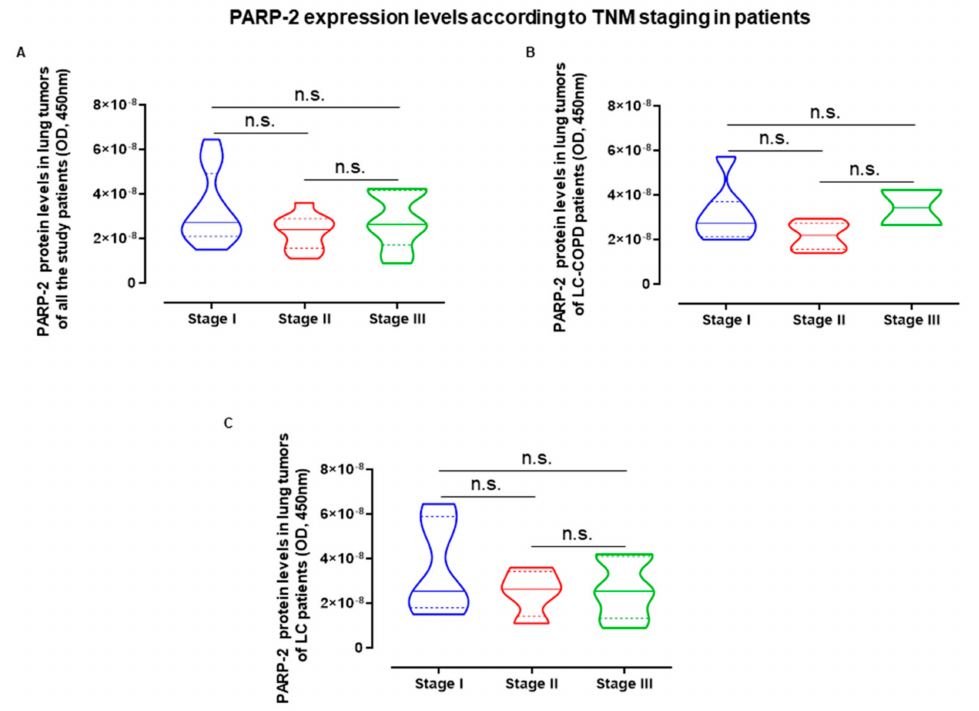
Figure 6. ( A – C ) Violin plots with median (continuous lines) and interquartile ranges (discontinuous lines) of PARP-2 expression levels in lung tumors according to cancer stages of all the study patients, LC-COPD and LC patients respectively. Statistical significance: n.s., no significance among cancer stages of patients.